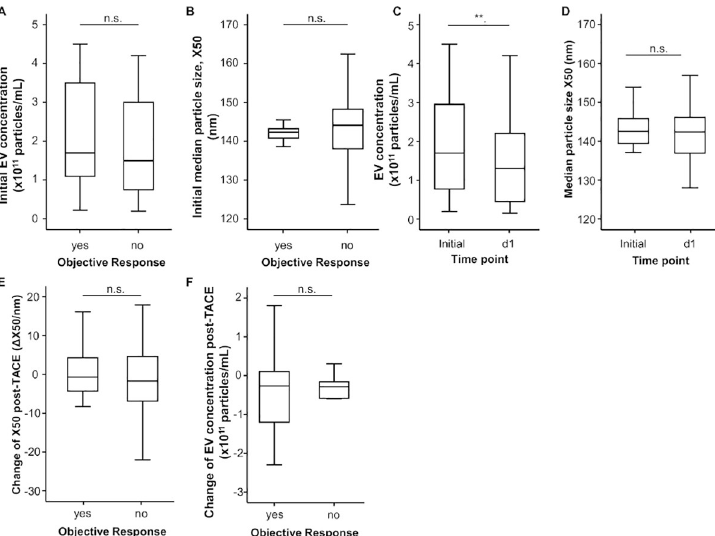
Fig 3. Particle size (X50) and particle concentration do not differ in patients with and without objective response (OR) after TACE. (A and B) Initial EVs concentrations and initial median particle sizes do not differ between patients with and without OR after TACE. (C) EVs concentration is significantly reduced in patients at day 1 compared to baseline, whereas (D) median particle size (X50) does not differ between baseline and day 1 after TACE. (E) The differences of X50 ( Δ X50) and (F) of EVs concentrations pre-/post-TACE do not differ between patients with and without